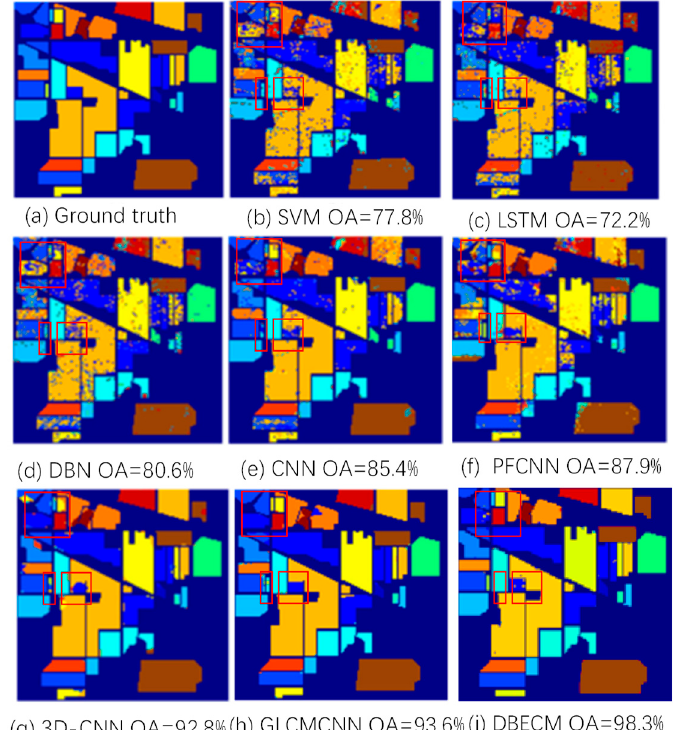
Figure 7. Accuracy of different methods in the Indian pines dataset. SVM: support vector machine. CNN: convolutional neural network.